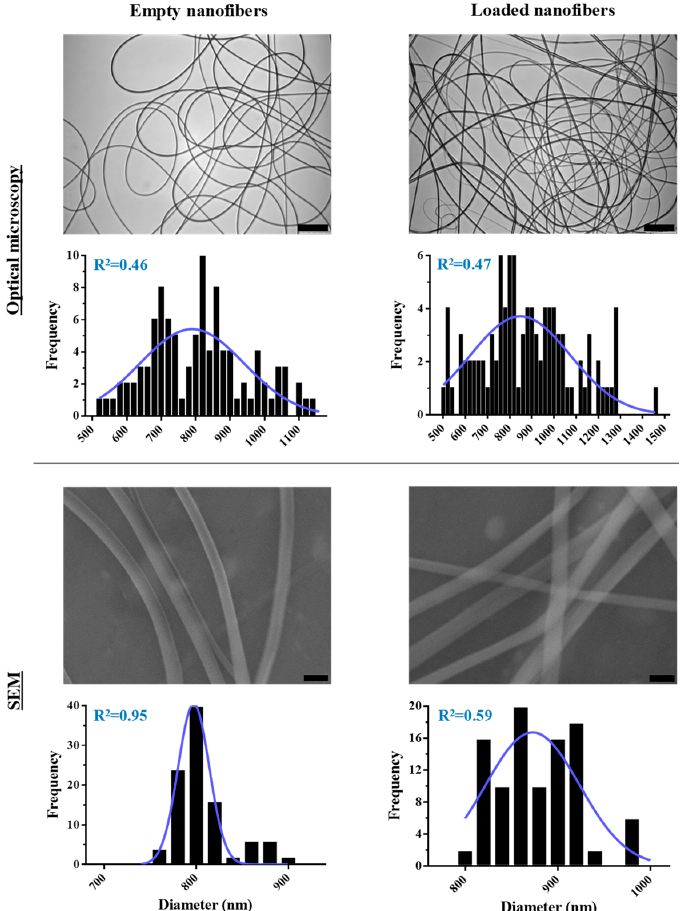
Figure 1. Optical microscopy and SEM analysis of optimized nanofibers. Representative optical microscopy and SEM images that include either empty or loaded nanofibers obtained by using optimized electrospinning parameters are shown (scale bars: 25 μ m for optical microscopy, and 1 μ m for SEM images). Corresponding frequency histograms of their diameters are also included. Each histogram was performed from the data obtained from several images until reaching 100 measurements. Best-fit adjustments (and their R 2 ) to a Gaussian distribution are indicated in blue. The low amount of encapsulated drug that was used in this work (3.5% all together) does not explain the increase in size that was observed in the loaded nanofibers, even more considering that